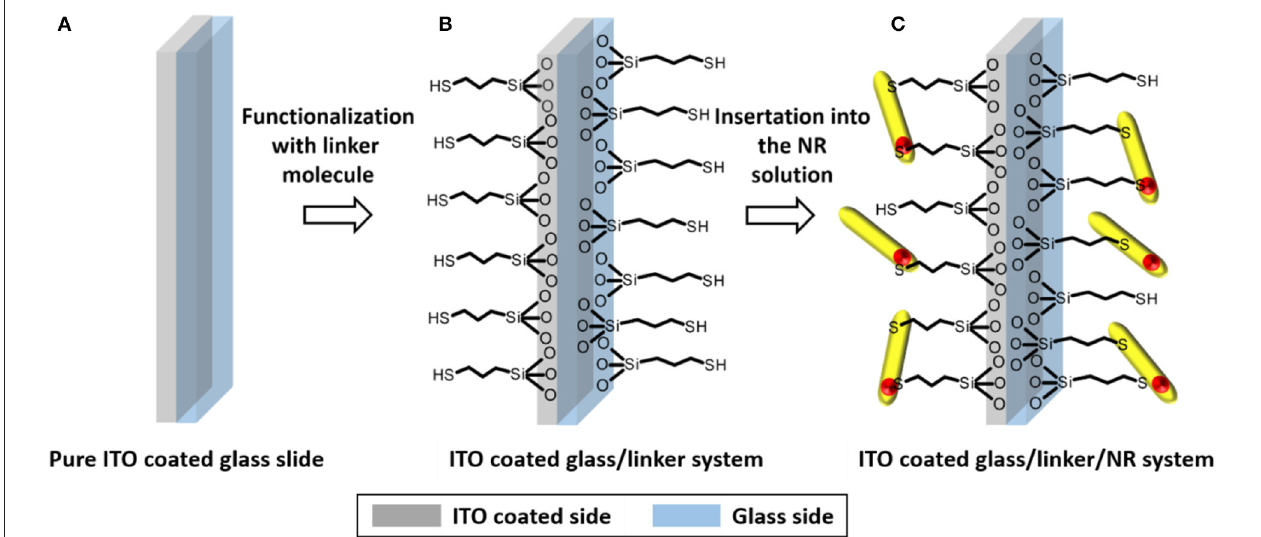
FIGURE 2 | Schematic illustration of the selective polishing of the different sides of the substrate. The result of this process are two comparable systems with completely different electronic interconnections, namely between NR and ITO or NR and glass.